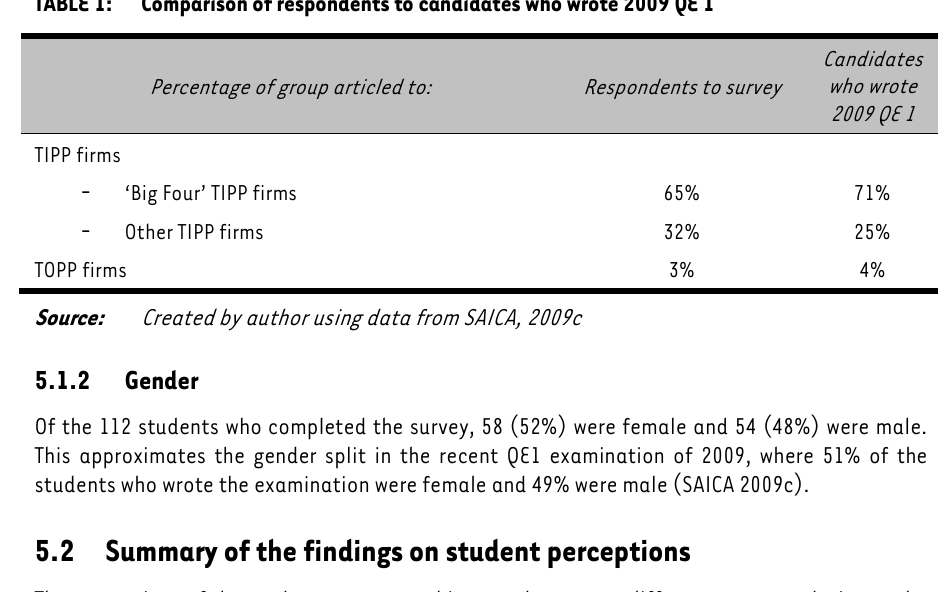
Comparison of respondents to candidates who wrote 2009 QE